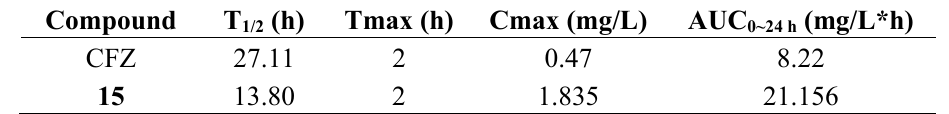
Table 4. Preliminary pharmacokinetic parameters of CFZ and 15 dosed orally in mice at 20